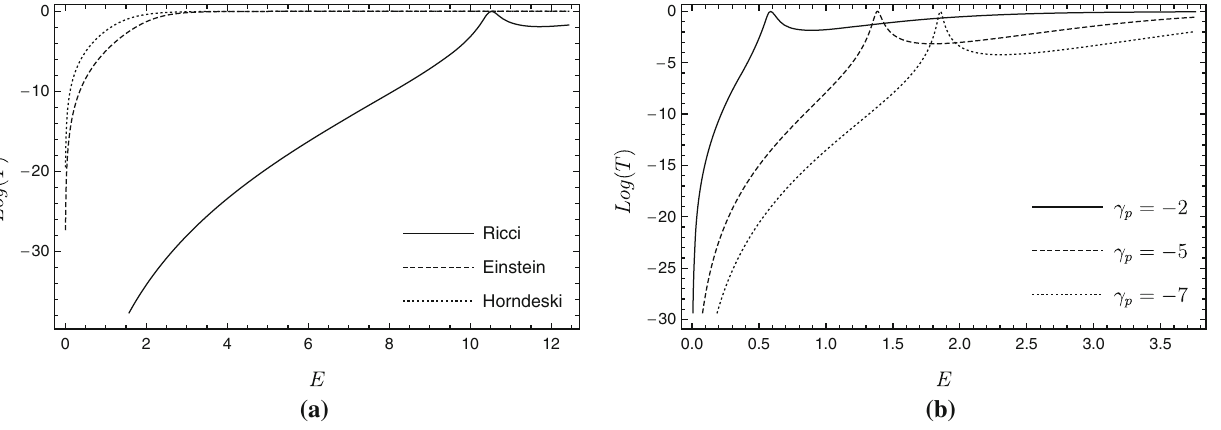
Fig. 12 The transmission coefficient for a p -form field in a Domain-wall with n = 1 , D = 10 and p = 3 as function of E = m 2 Horndeski and b